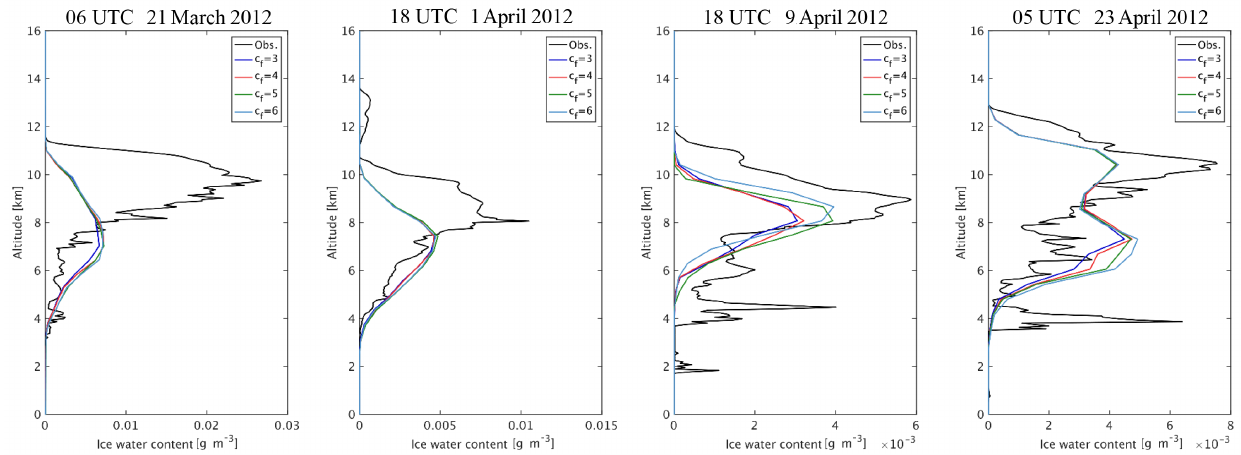
Figure 11. Vertical profiles for the mean observed IWC from CALIPSO and the simulated IWC with various c f for the dust events on 21 March and 1, 9, and 23 April